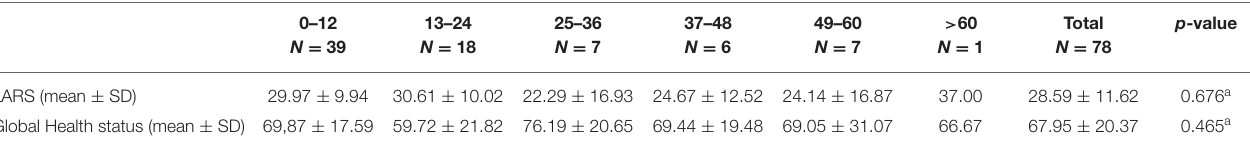
TABLE 4 | LARS and global health status according to time to follow-up